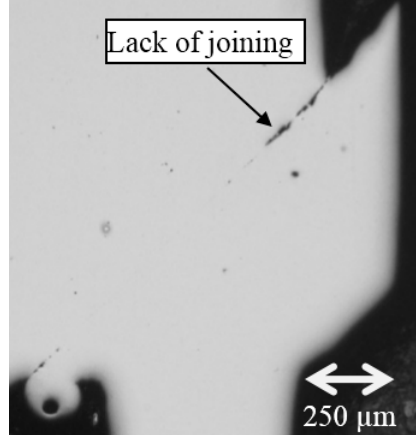
Figure 7. Example of a lack of joining (Mirror polish without etching) for a sample welded with the selected parameters ( F w ; I w ; t w ; C s ) = (2600 N; 14 kA; 10 ms; 0.8 mm).